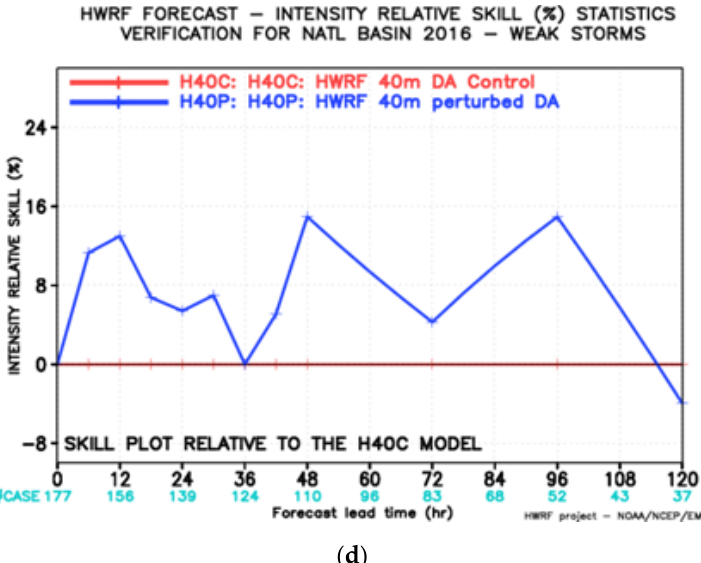
Figure 11. Same as Figure 8, but stratified for strong storms (Vmax greater than 50 knots) track ( a ) and intensity ( b ) forecast skills, and weak storms (Vmax less than 50 knots) track ( c ) and intensity ( d ) forecast skills.